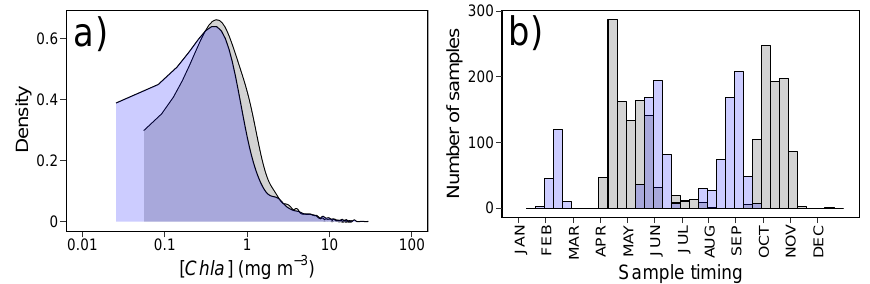
Figure 2. ( a ) Density function distribution of in situ chlorophyll-a concentration for the Northwest Atlantic (grey) and Northeast Pacific (lavender), and ( b ) total number of in situ samples available in the entire dataset for each